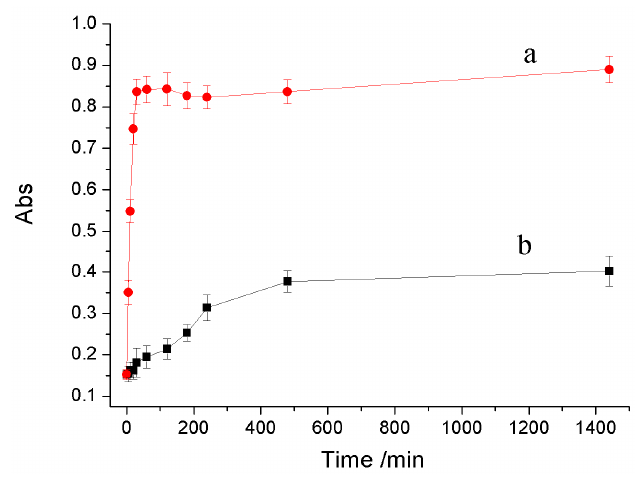
Figure 8. Kinetics of catalytic reaction and stability of chelating product. Catalytic reaction in the present ( a ) and absent ( b ) of Au/MWCNTs.